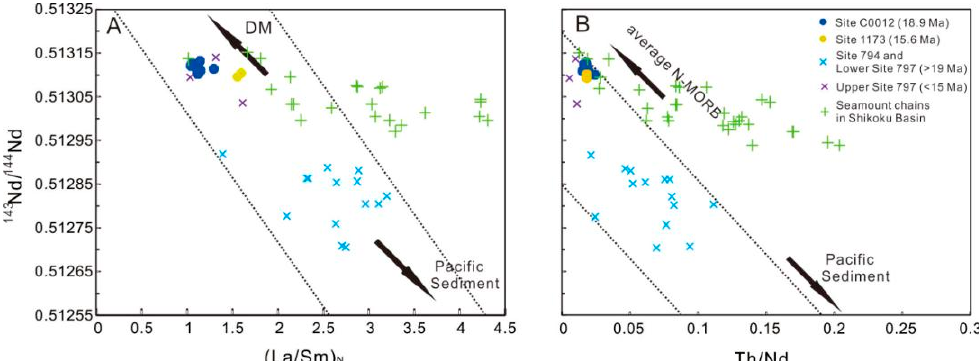
Figure 17. Plots of 143 Nd/ 144 Nd versus (La/Sm) N ( A ), 143 Nd/ 144 Nd versus Th/Nd ( B ) of Site C0012, 1173 volcanic rocks from the Shikoku Basin. Data sources as for Figure 10. Figure 17A is modified from Reference [91]; Figure 17B is modified from Reference [92]; the data of Pacific MORB, Pacific Sediment are from Reference [58].